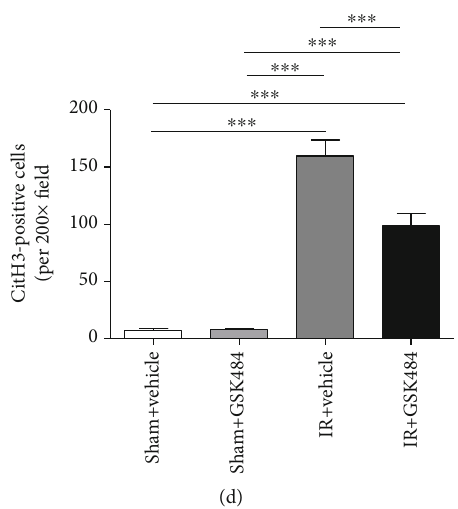
Figure 3: E ff ect of GSK484 on the PAD4 expression and citH3 accumulation in the lung after renal IR. (a, b) Representative images of immunohistochemical staining and analysis of PAD4-positive cells in lung sections from di ff erent groups (scale bar: 50 μ m). (c, d) Immuno fl uorescence images and analysis of H3cit-positive cells in the lung (scale bar: 20 μ m). The data are the means ± SEMs ; n = 6 ; ∗∗ p < 0 : 01 and ∗∗∗ p < 0 : 001